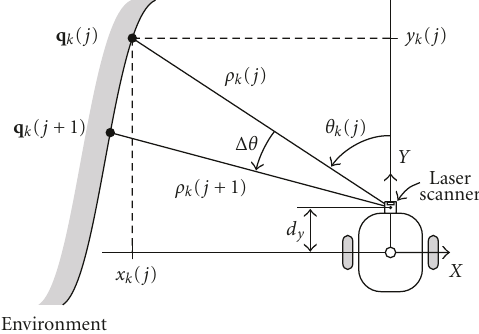
Figure 3: Local cartesian coordinates of the laser point q k ( j ). a fast computation of the goal point.